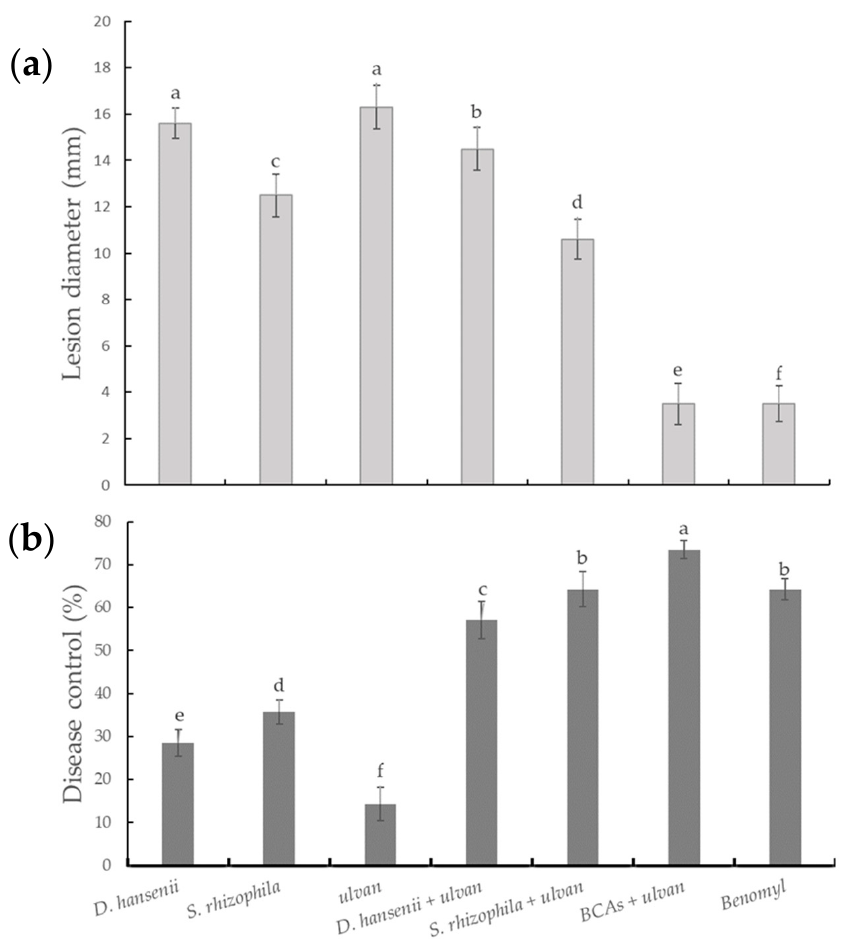
Figure 1. Effect of D. hansenii , S. rhizophila, and ulvan as individual or mixed treatments on the lesion diameter ( a ) and disease control ( b ) of fruit rot induced by F. proliferatum on muskmelon. Bars are the mean of five replicates with three fruits per replicate ± Standard deviation. Different letters in each column indicate significant difference ( p ≤ 0.05). BCAs: Biological control agents ( D. hansenii + S. rhizophila ). Table 1. Synergistic biocontrol activity of D. hansenii , S. rhizophila, and ulvan against F. proliferatum on muskmelon fruit.